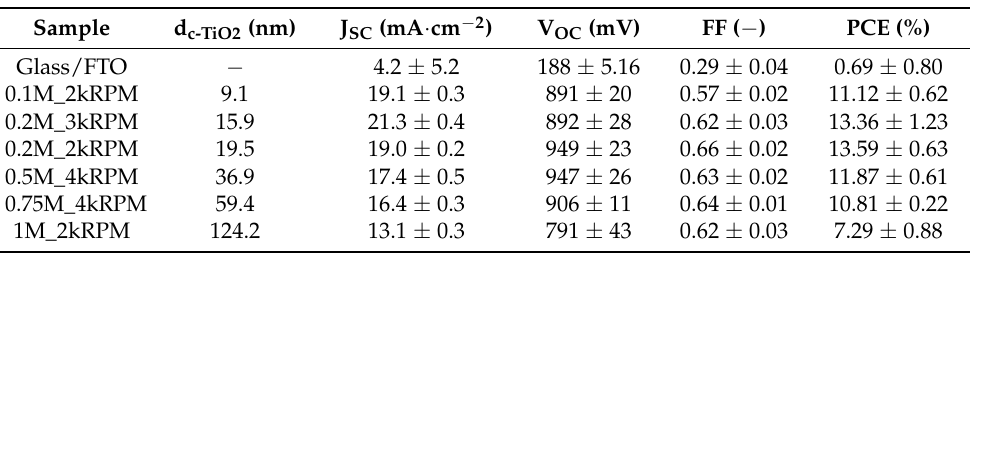
cells with a compact TiO 2 layer of different thicknesses (forward scan). The samples are named after